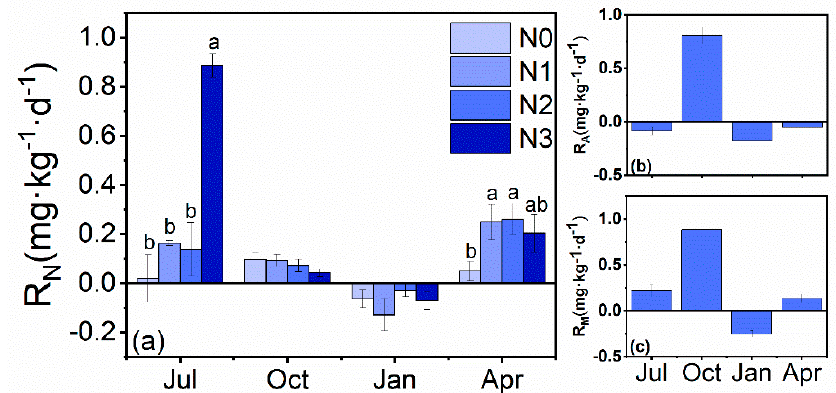
Figure 4. Seasonal variations of soil net nitrification (R N , a ) in different N fertilizer treatments, soil net ammonification (R A , b ), and mineralization (R M , c ). The error bar indicates mean ± SE ( n = 9 for R N , n = 36 for R A and R M ). Different letters above the bars indicate significant differences (ANOVA followed by Duncan’s tests, p < 0.05).